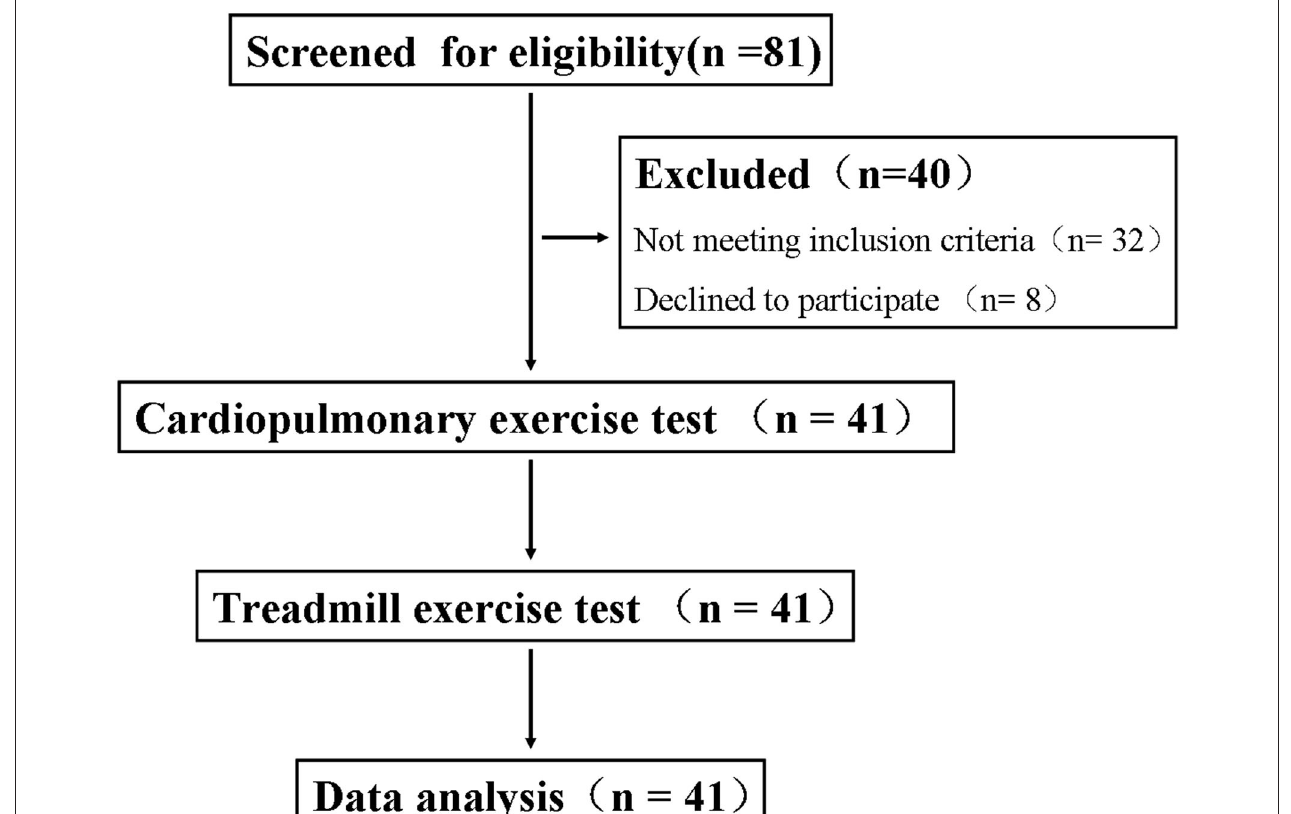
FIGURE 1 | Flow diagram of the